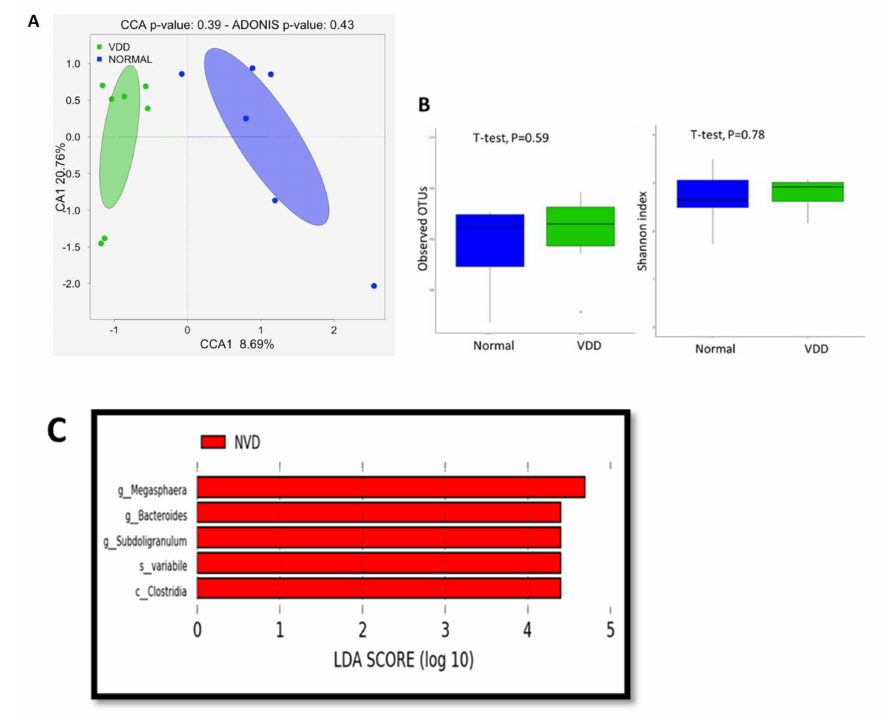
Figure 5. Vitamin D deficiency affects the gut bacterial communities: ( A ) canonical correspondence analysis (CCA) was performed to study the beta diversity between stool microbiome in VDD and NVD participants; ( B ) Alpha-diversity using the observed OTU and Shannon index based on Bray– Curtis distance–s and ( C ) Histogram of the log 10 transformed LDA scores were computed for features that showed differential abundance between VDD and NVD